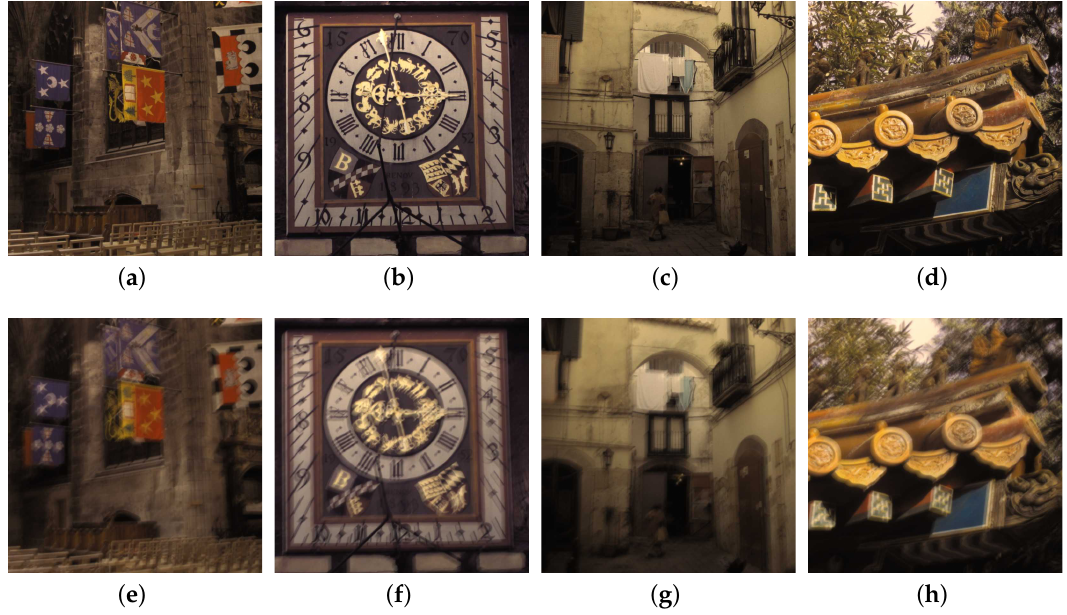
Figure 2. A real-world benchmark dataset: ( a – d ) the four original images; and ( e – h ) the blurry